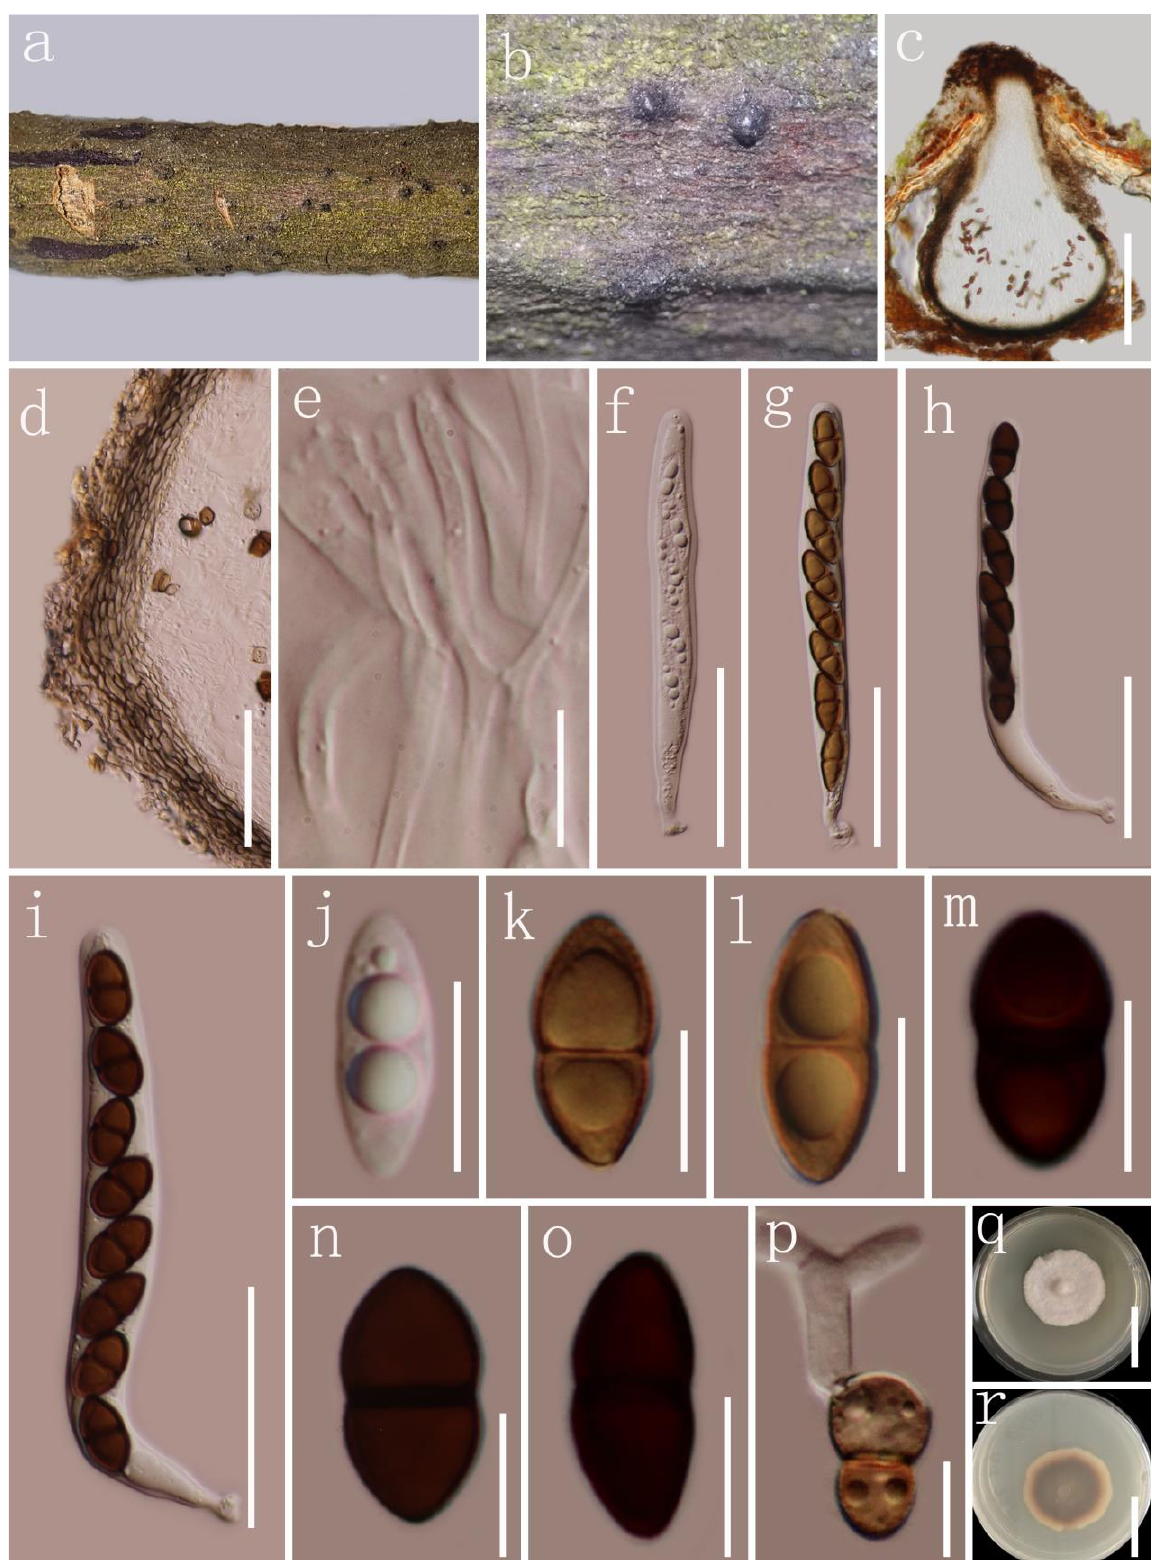
Figure 4. Chromolaenicola sapindi (HKAS 122789, holotype). ( a , b ) Appearance of ascomata on host substrate; ( c ) section of ascoma; ( d ) peridium; ( e ) hamathecium; ( f ‒ i ) asci; ( j ‒ o ) ascospores; ( p ) germinated ascospore; ( q , r ) culture characters on PDA (q from above, r from below). Scale bars, ( c ) 200 μm; ( d , f ‒ i ) 50 μm; ( e , j ‒ p ) 10 μm; ( q , r ) 30 mm. Dictyoarthrinium S. Hughes, Mycological Papers 48: 29 (1952).